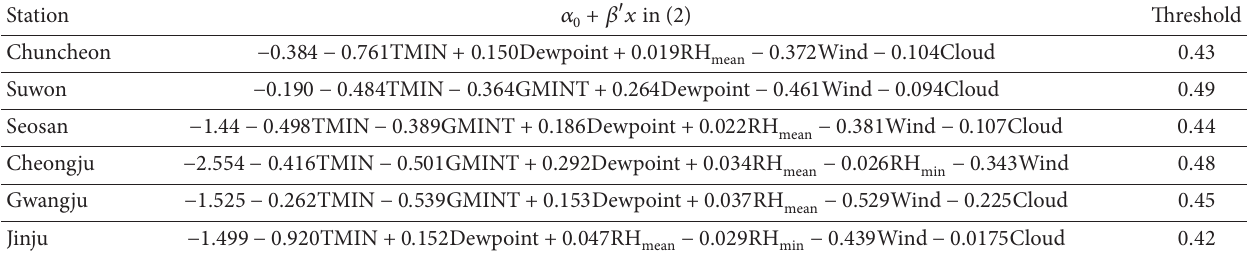
Table 3: Logistic regression models and threshold values for stations.